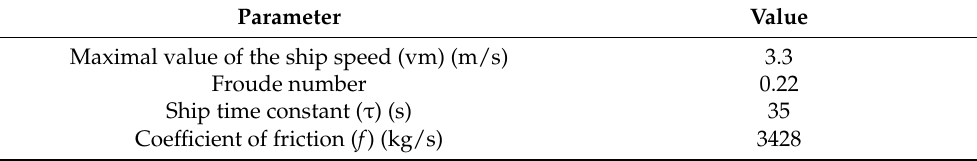
Table 2. Identified parameters. Parameter Value Maximal value of the ship speed (vm) (m/s) 3.3 Froude number 0.22 Ship time constant ( τ ) (s) 35 Coefficient of friction ( f ) (kg/s)